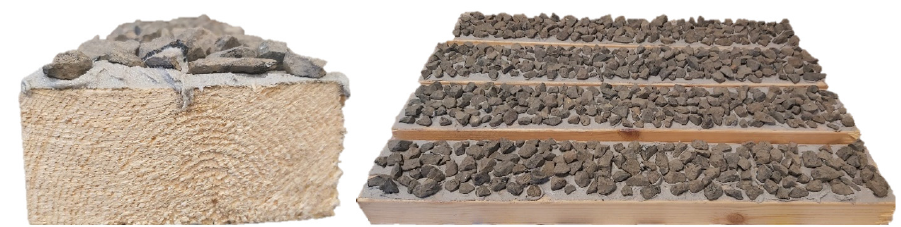
Figure 1. The proposed production method of the rigid connection between timber and concrete layers by gluing granite chips.